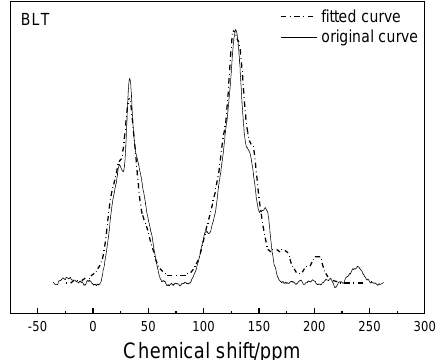
Figure 3. Experimental and calculated 13 C-NMR spectrum of the Bulianta coal.